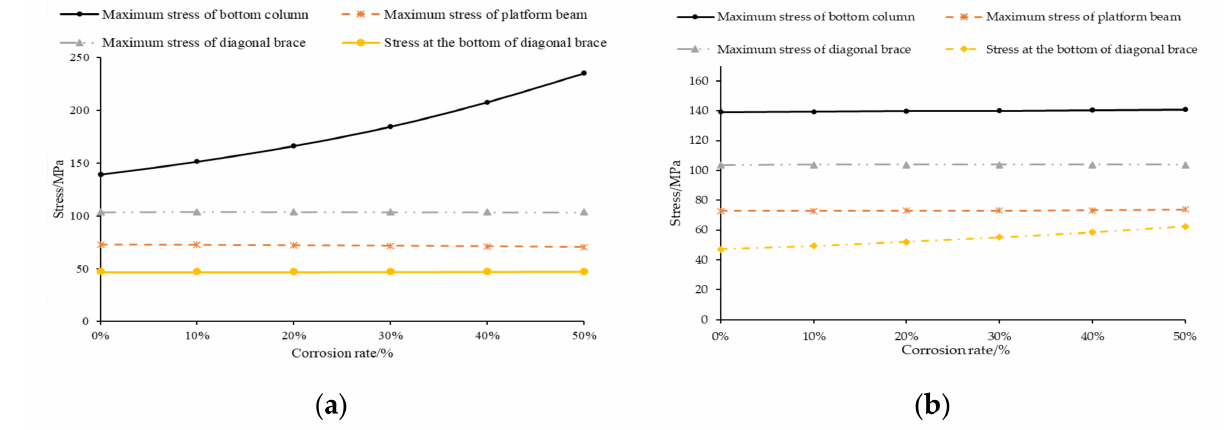
Figure 5. The stress variation of the headframe with element corrosion. ( a ) stress variation with column corrosion; ( b ) stress variation when brace corrosion.